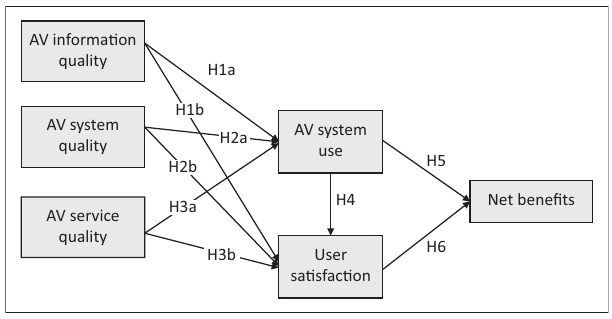
FIGURE 1: Audio–visual implementation success: Research model and hypothesis